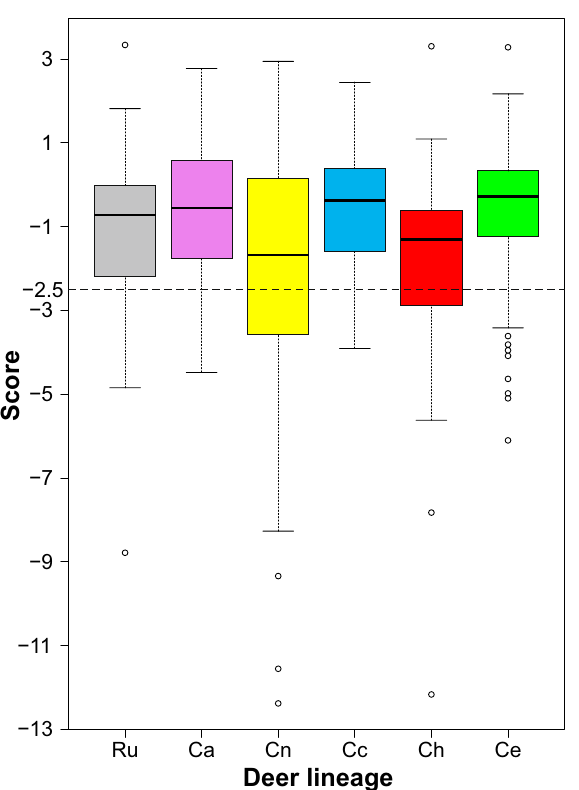
Figure 7. Box-plots of Provean scores in various deer species: Ru— R. unicolor and timorensis ; Ca— C. albirostris ; Cn— C. nippon ; Cc— C. canadensis ; Ch— C. hanglu ; Ce— C. elaphus. The scores quantify negative effects of amino acid substitutions on proteins. The thick line indicates the median, the box shows quartile ranges, and the whiskers denote the range without outliers shown as circles. The dashed line shows the threshold assuming deleterious (< − 2.5) and neutral (> − 2.5) mutations 94